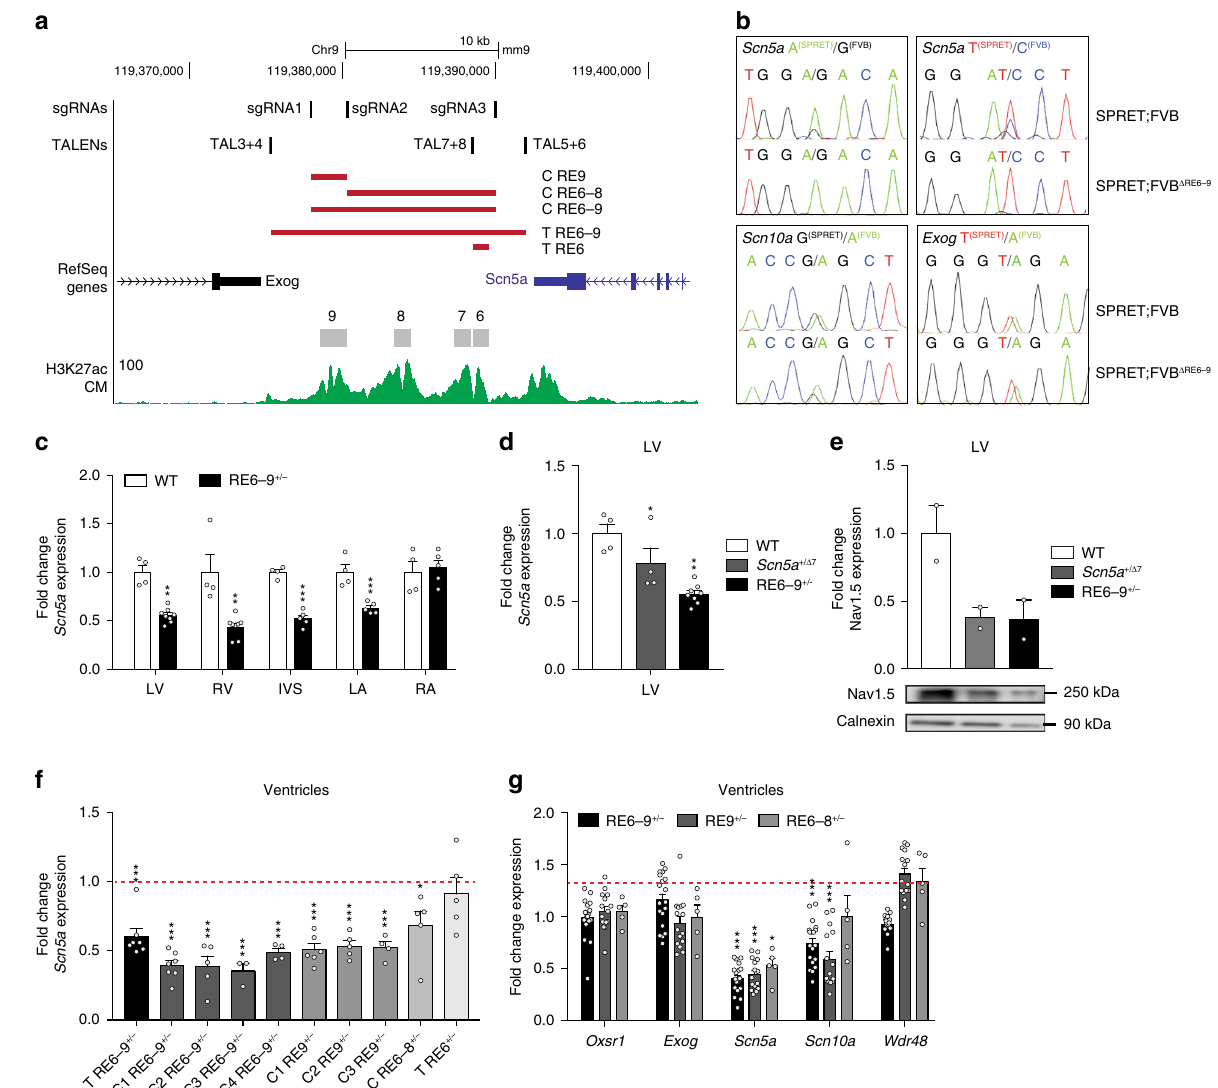
Fig. 5 Integrity of the enhancer cluster RE6-9 is required for its function in the heart and cardiac Scn5a expression. a UCSC browser view of the enhancer cluster RE6-9 and the deletions of regulatory elements within this region by TALEN and CRISPR/Cas9 technology (red rectangles). Included location of the TALENs and CRISPR/Cas9 sgRNAs design and cardiomyocyte-speci fi c H3K27ac ChIP 33 . b Sequence traces of a genetic variant in Scn5a , Scn10a and Exog from SPRET;FVB and SPRET;FVB Δ RE6-9 F1 hybrids. c Fold change expression level of Scn5a in different compartments of heart from 8-week old RE6-9 + / − mice compared to wildtype (WT). P values were calculated using unpaired Student ’ s t test. WT n = 4; RE6-9 + / − n = 5 (LA, RA, IVS); RE6-9 + / − n = 7 (LV, RV). ** P < 0.01; *** P < 0.001. d Fold change expression level of Scn5a from left ventricle of 8-week old RE6-9 + / − and Scn5a + / Δ 7 mice. P values were calculated using unpaired Student ’ s t test. WT n = 4; Scn5a + / Δ 7 n = 4; RE6-9 + / − n = 5. * P < 0.05; ** P < 0.01. e Fold change expression level of Nav1.5 from left ventricle of 8-week old RE6-9 + / − and Scn5a + / Δ 7 mice. WT n = 2; Scn5a + / Δ 7 n = 2; RE6-9 + / − n = 2. f Fold change expression level of Scn5a from various established mouse lines (8-week old) with deletions of regulatory elements from the enhancer cluster. P values were calculated using unpaired